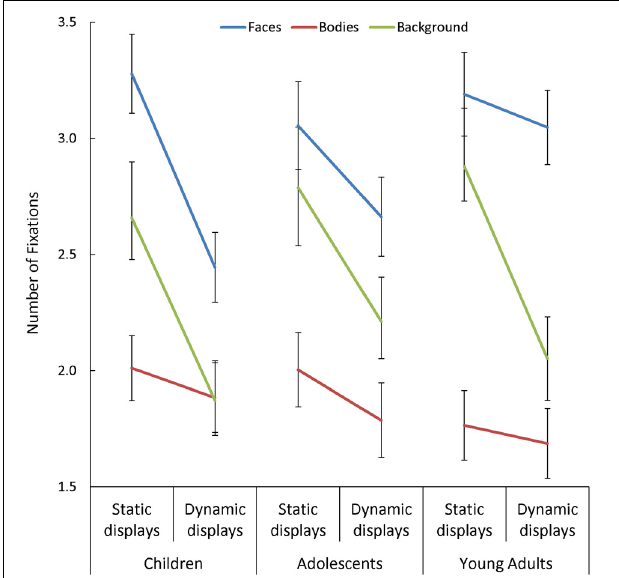
FIGURE 2 | The number of fixations made by children, adolescents, and young adults within the each area of interest (AOI; faces, bodies, and backgrounds) for the static and dynamic